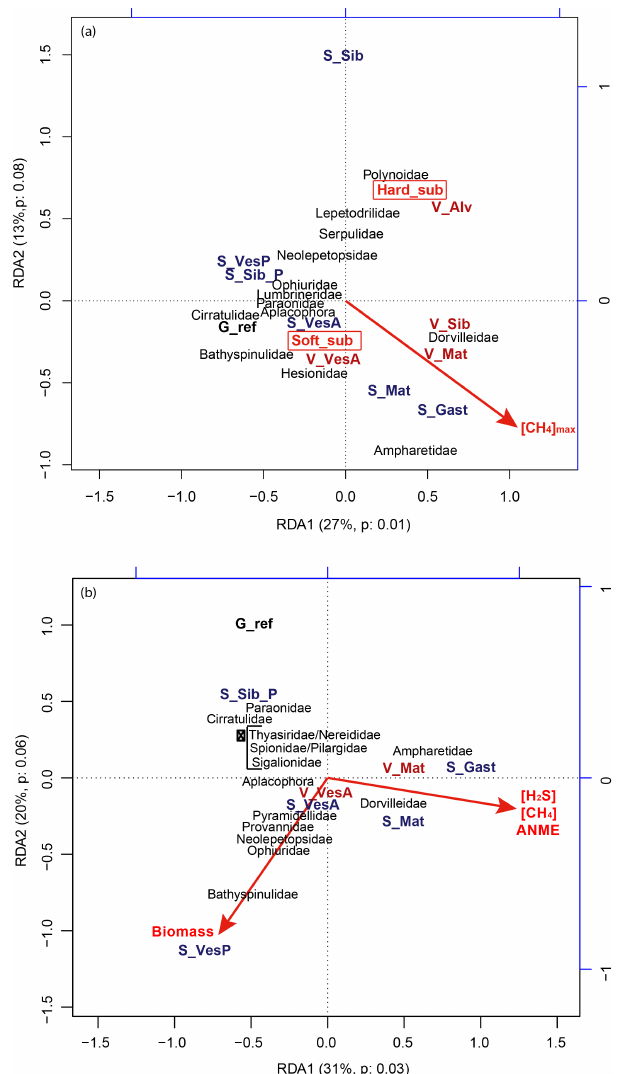
Figure 9. Canonical redundancy analysis (RDA, scaling type 1) of Hellinger-transformed macrofaunal densities as a function of qual- itative and normalised quantitative environmental conditions for all assemblages (a) or for soft-sediment assemblages (b) . Only signifi- cant explanatory variables are shown (a) methane concentration and substratum type; (b) first axis of the prior co-inertia analysis and engineer species biomass). Only the names of the taxa that showed good fit with the first two canonical axes (fitted value >0.20) are shown on the